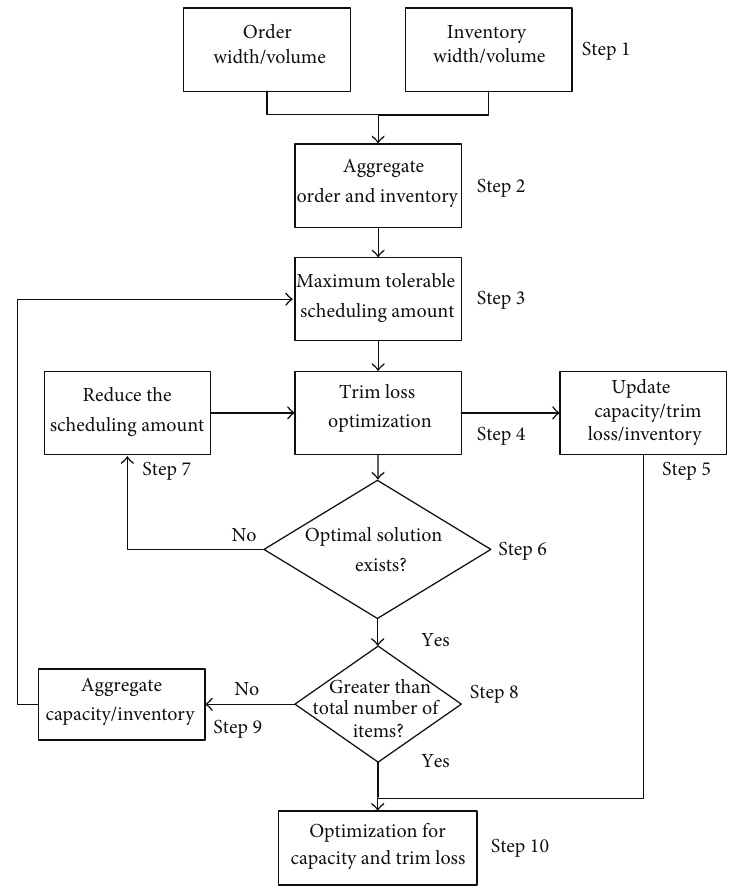
Figure 3: Decision